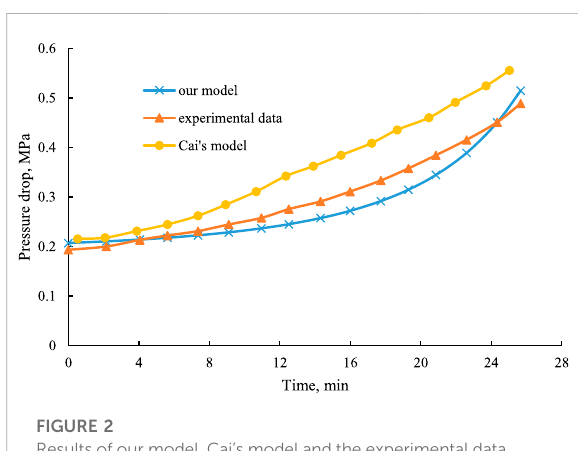
FIGURE 2 Results of our model, Cai ’ s model and the experimental